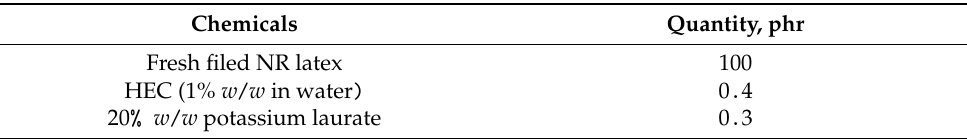
Table 2. Formulation is used to prepare creamed concentrated